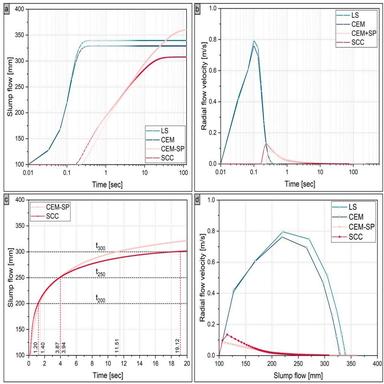
Slump flow (a) and radial flow velocity (b) development over time (logarithmically represented) of the four mixes tested. (c) Development of slump flow within the first 20 sec, including flow time identification for 200, 250 and 300 mm. (d) Velocity-dependent slump flow development of the four investigated mixes.